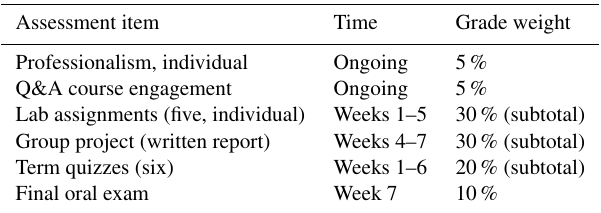
Table 3. GEOE/L 221 course evaluation in fall